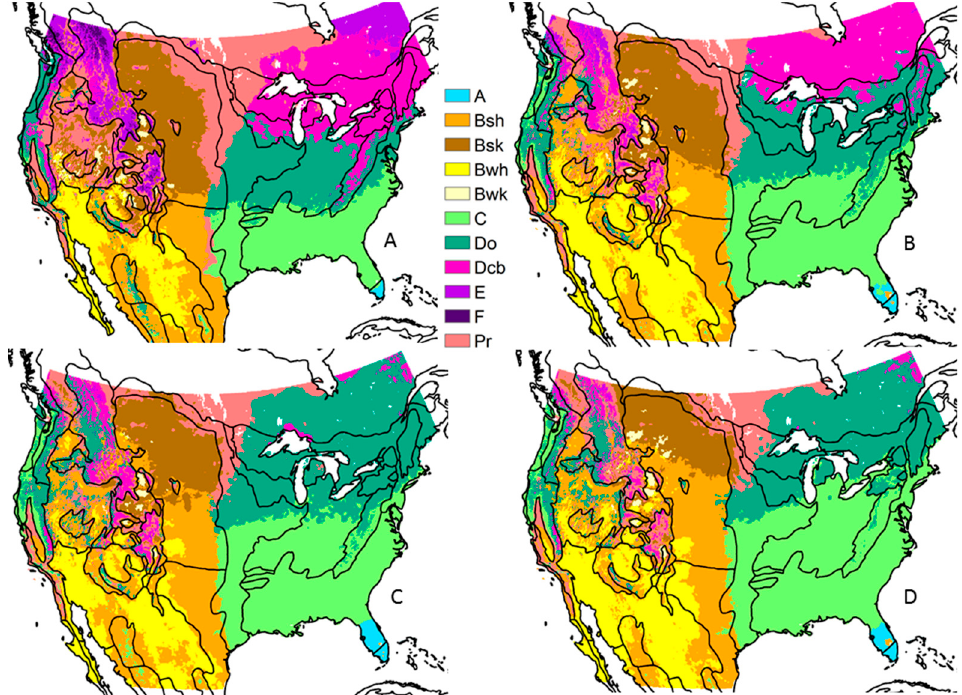
Figure 3. Current Köppen-Trewartha climate types (panel A ) and Köppen-Trewartha climate types under GFDL-ESM2G RCP8.5 (panel B ), CanESM2 RCP8.5 (panel C ), and HadGEM2-ES RCP8.5 (panel D ). For the legend, A = Tropical (Savanna), C = Subtropical and Mediterranean, Dca = Hot Continental, Dcb = Warm Continental, E= Boreal, F = Polar, Bwh = Subtropical desert, Bsh = Subtropical steppe, Bwk = Temperate desert, Bsk = Temperate steppe, Pr = Prairie. Bailey’s [12] ecological divisions are outlined for